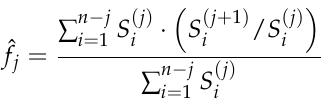
Table 1. Statistics for the first year capital on the 500 simulated triangles. The mean first year capital, the standard deviation of the capital around that mean and the mean absolute and relative deviations (MAD/MRAD) from the true value are displayed. The latter are computed using both a standard and the robust Huber M-estimator, Huber (1981). The mean reserves estimated with chain-ladder are 101.87, which are consistent with the reserves calculated with our model, i.e., n ( 1 100,000 ( 1 2 19 ) 0.001 = 100.00. − Method Mean Std. Dev. MAD MRAD Rob. MAD Rob. MRAD Theoretical value 18.37 3.92 0 0% 0 0% SCOR, without